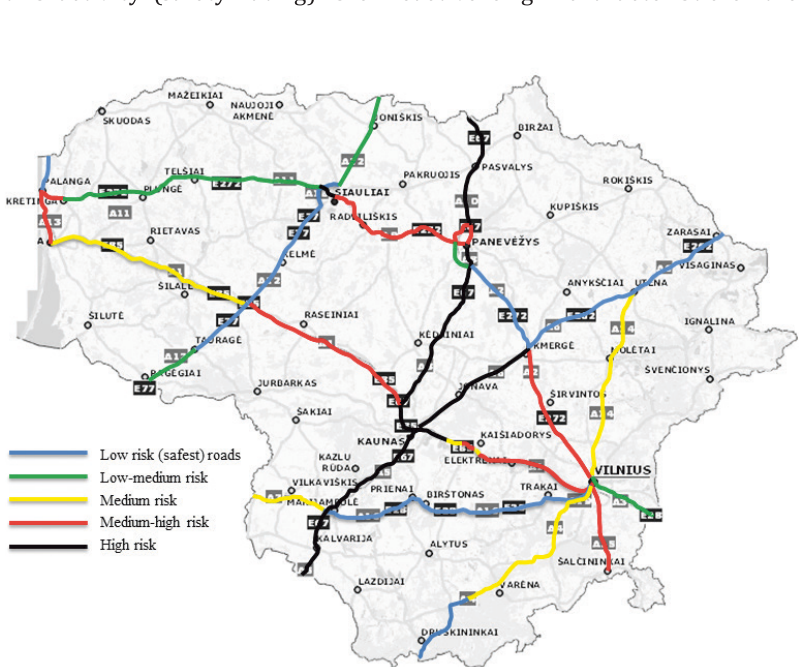
Figure 1. Road safety categories on main roads considering the